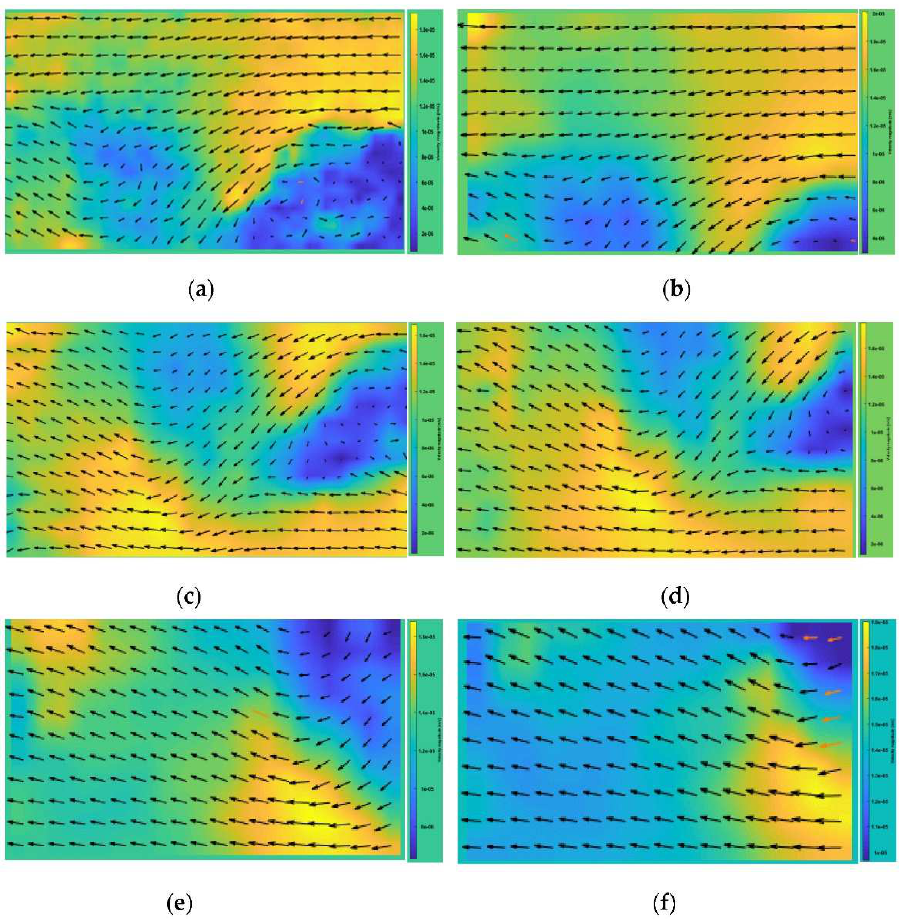
Figure 8. Flow velocity clouds of specimen sections with different mass ratios: ( a ) mass ratio of 3%—specimen K cross-sectional velocity cloud; ( b ) mass ratio of 3%—specimen M cross-sectional velocity cloud; ( c ) mass ratio of 4%—specimen K cross-sectional velocity cloud; ( d ) mass ratio 4%—specimen M cross-sectional velocity cloud; ( e ) mass ratio 5%—specimen K cross-sectional velocity cloud; ( f ) mass ratio 5%—specimen M cross-sectional velocity cloud.